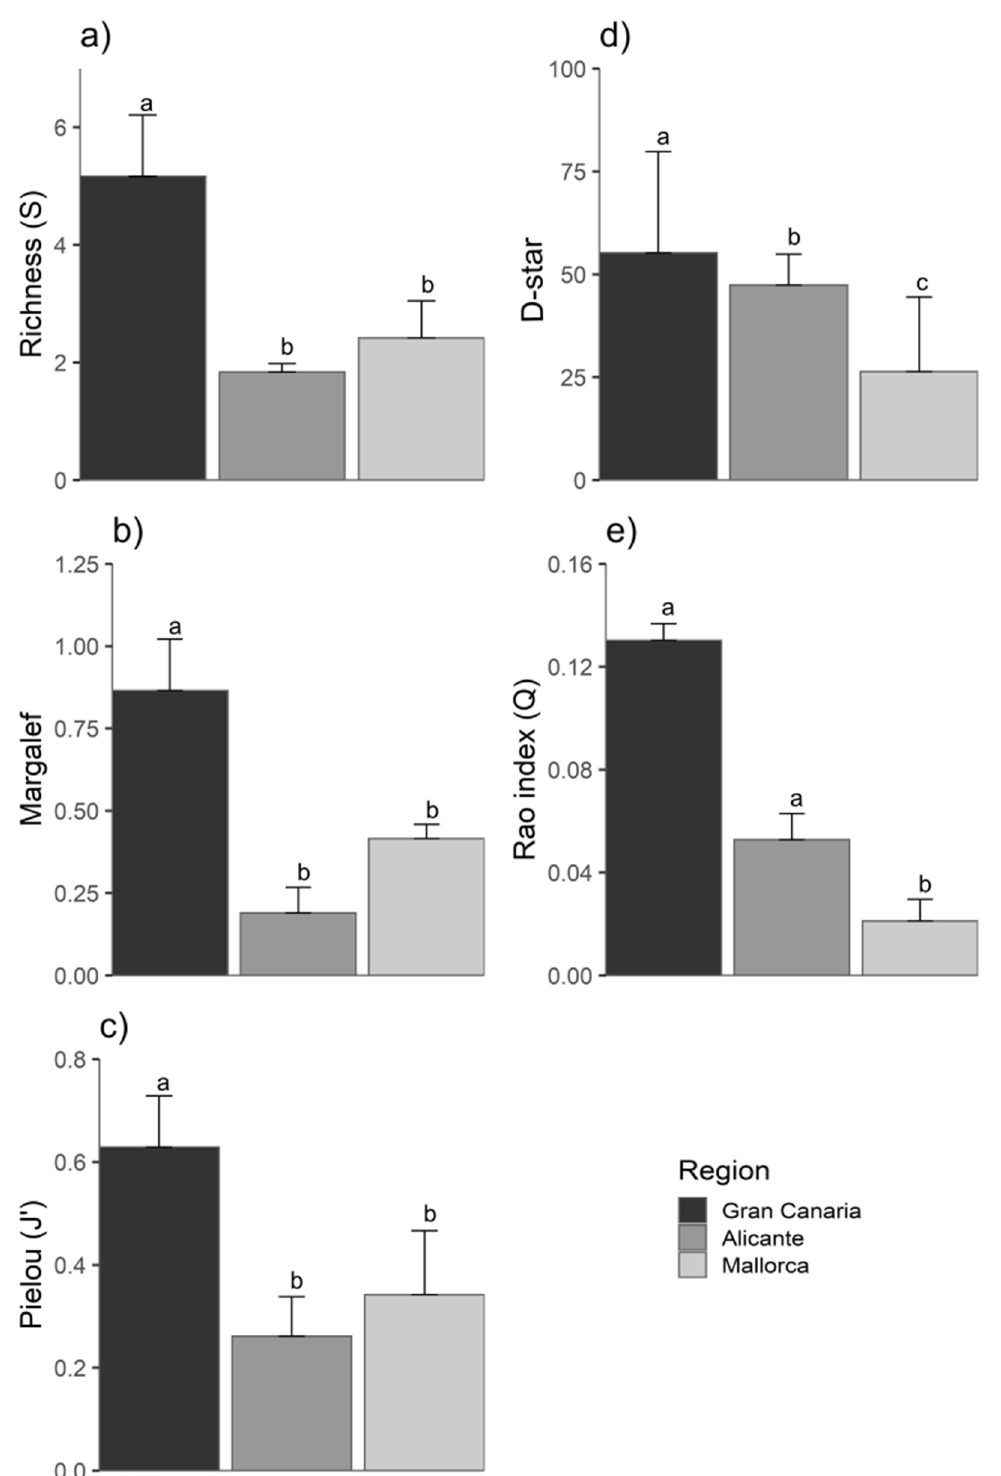
Figure 5 . Differences in biodiversity indices between regions: ( a ) Species Richness (S), ( b ) Margalef index, ( c ) Pielou index (J’), ( d ) D-star index and ( e ) RAO index. Different letters above denote statistically significant differences between regions. Errors are + SD of means per month. ( n = 9) .